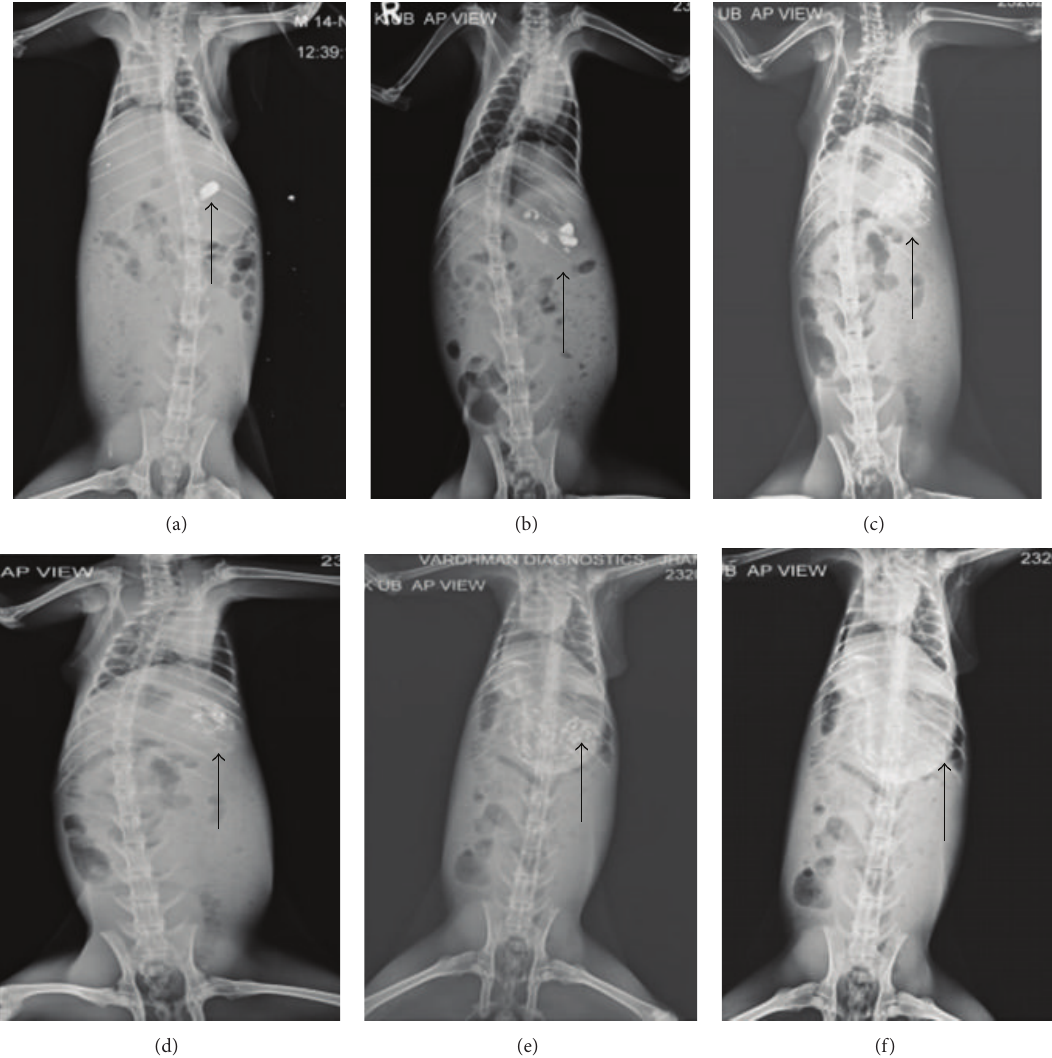
Figure 7: Radiographic images showing the presence of BaSO 4 loaded floating hollow microspheres in the stomach at different time intervals. Images were taken after (a) 0hr, (b) 1hr, (c) 2hr, (d) 3 hr, (e) 4hr, and (f) 6 hr.